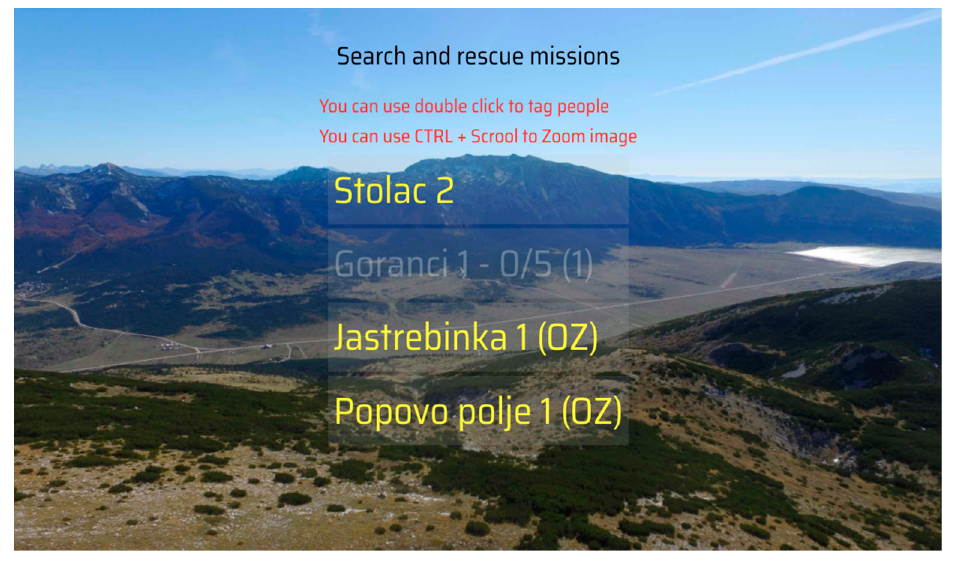
Figure 9. Main screen of the developed web application for detection accuracy comparison between the expert and the ScoreMap to ROI algorithm.